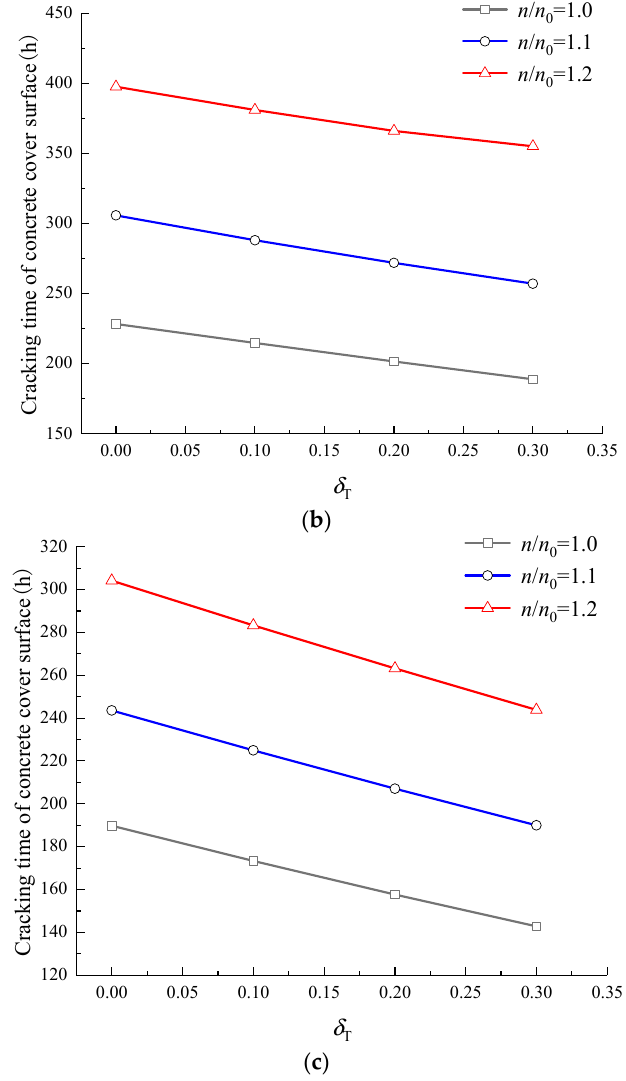
Figure 13. Effects of load, n , and n / n 0 on the CLC time of CCS. ( a ) n = 2; ( b ) n = 3; ( c ) n = 4. Table 2. Effects of load on the CLC time of CCS.